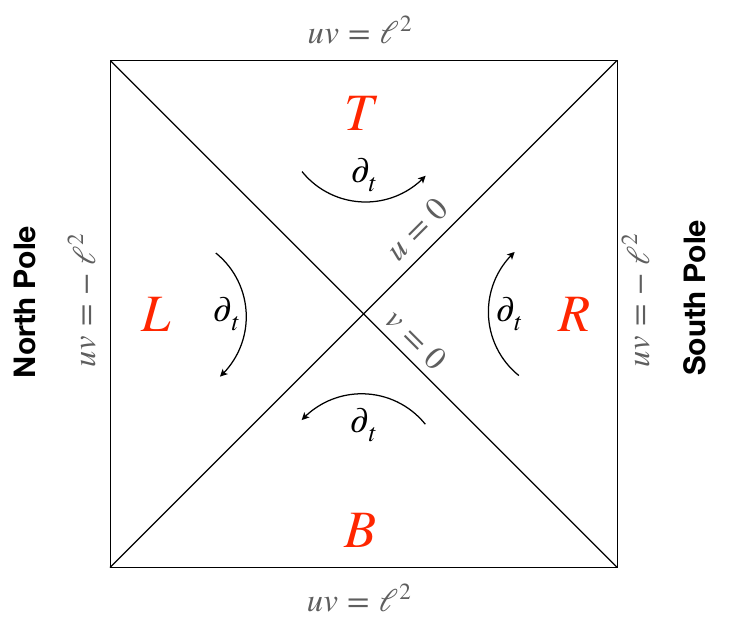
Figure 1 . Penrose diagram of de Sitter space. By complexifying the static time coordinate, we can cover each of the four static patches. The (cid:13)ow of the timelike Killing vector @ t is indicated with arrows in each